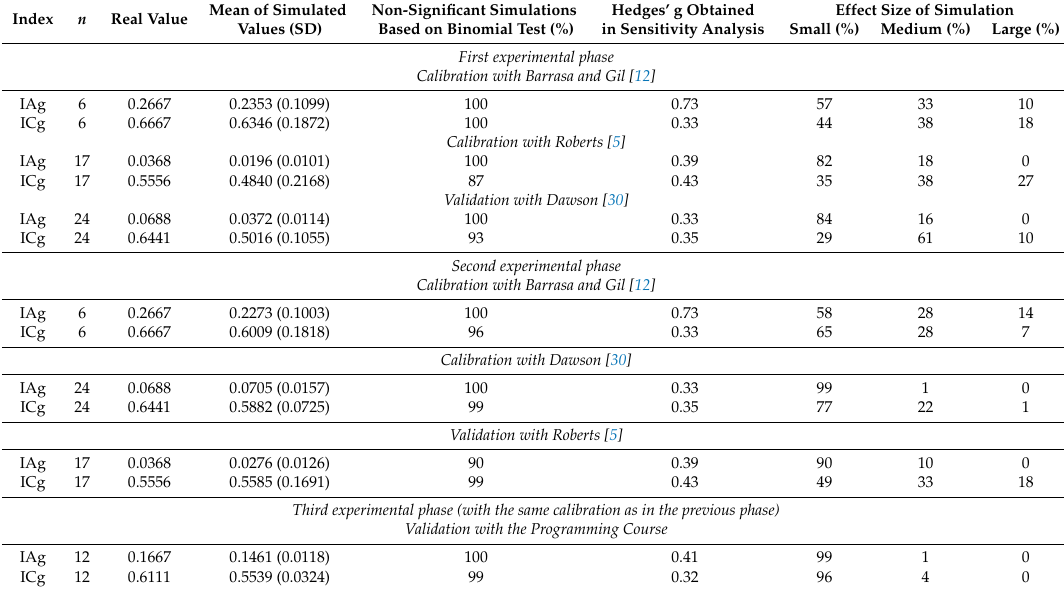
Table 3. Real and simulated values, percentages of non-significant simulations and of simulations with small, medium and large effect size, and Hedges’ g obtained in sensitivity analysis for the Index of Association of a group (IAg) and the Index of Coherence of a group (ICg) in calibration and validation studies. Note: n = sample size of calibration and validation